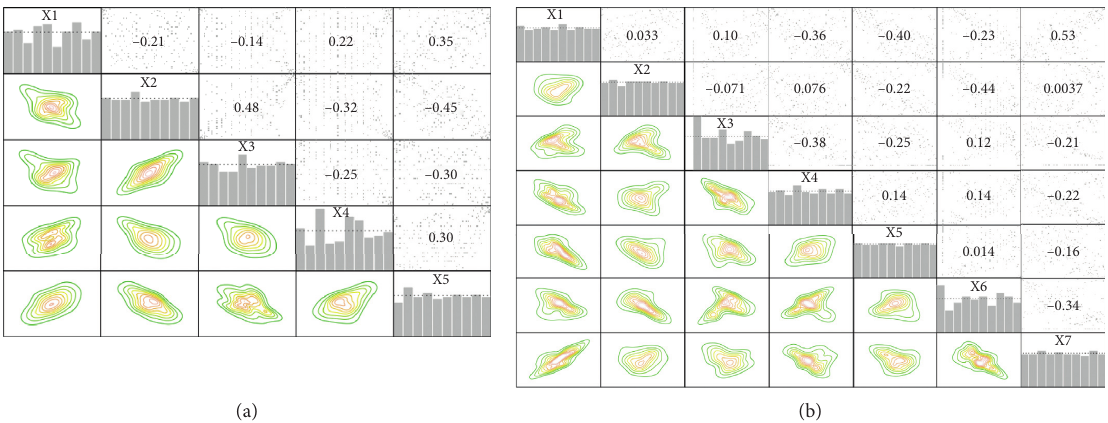
Figure 8: From left to right: the contour plots (lower triangular) with the scatter plots (upper triangular) and the correlations computed by Kendall’s tau (the diagonal) (generated by the pairs.copuladata function from the VineCopula package). Table 6: The values of the selection model criteria and the mixture weights for each model.